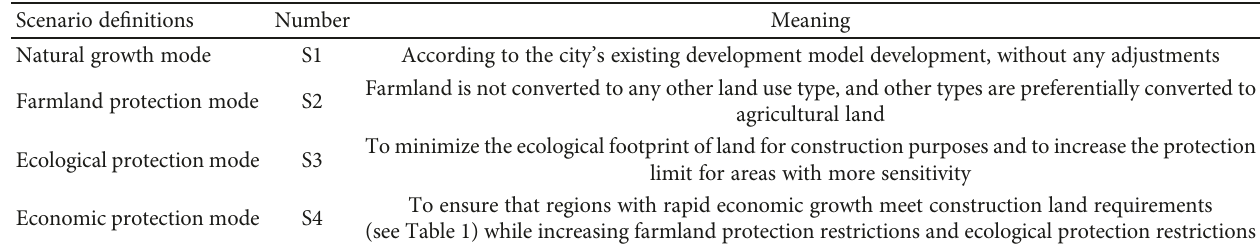
Table 8: De fi nitions of the four scenarios used in the